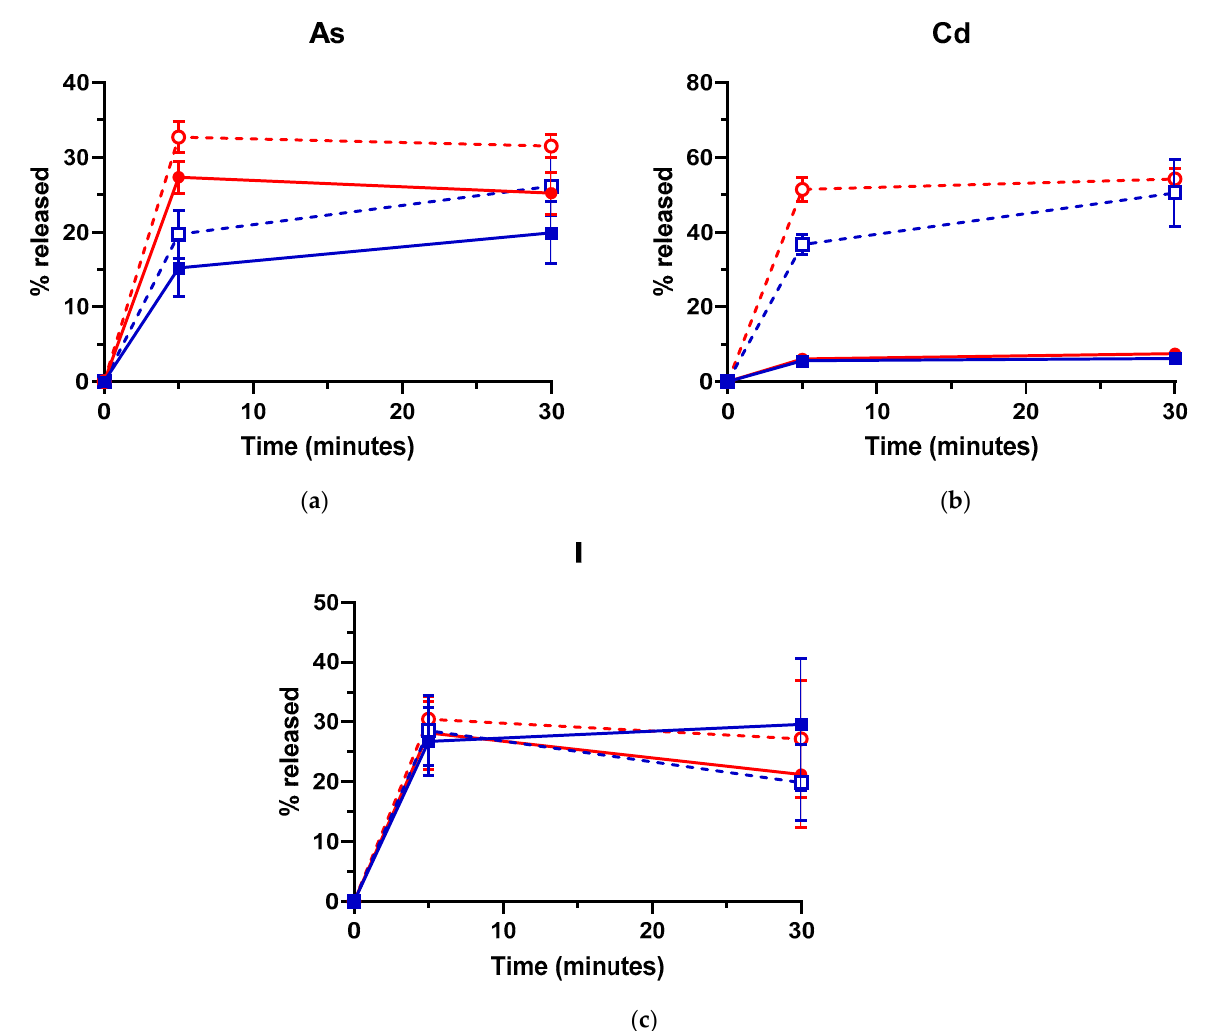
Figure 3. Percentage of arsenic (As) ( a ), cadmium (Cd) ( b ) and iodine (I) ( c ) released from Laminaria hyperborea blades after Ultrasound (US) (red symbols and lines: ● , ) and Control treatments (no US; blue symbols and lines: , ). Treatments were carried out with (empty symbols, discontinuous lines: - - , - - ) or without ( fi lled symbols, continuous lines: ● , ) the addition of EDTA (0.1 N). Treatment temperature: 50 °C. Error bars correspond to the standard deviations.